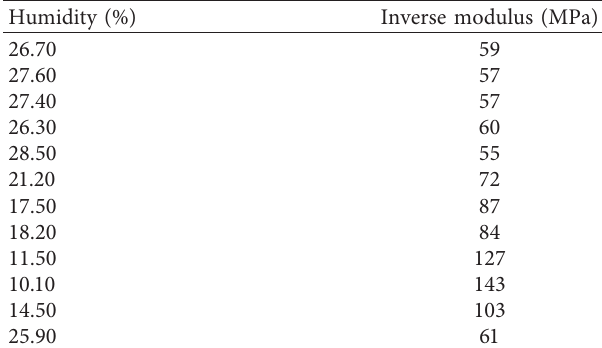
Figure 8: Correlation between inversion modulus of subgrade and Table 7: Subgrade humidity and inversion modulus data.